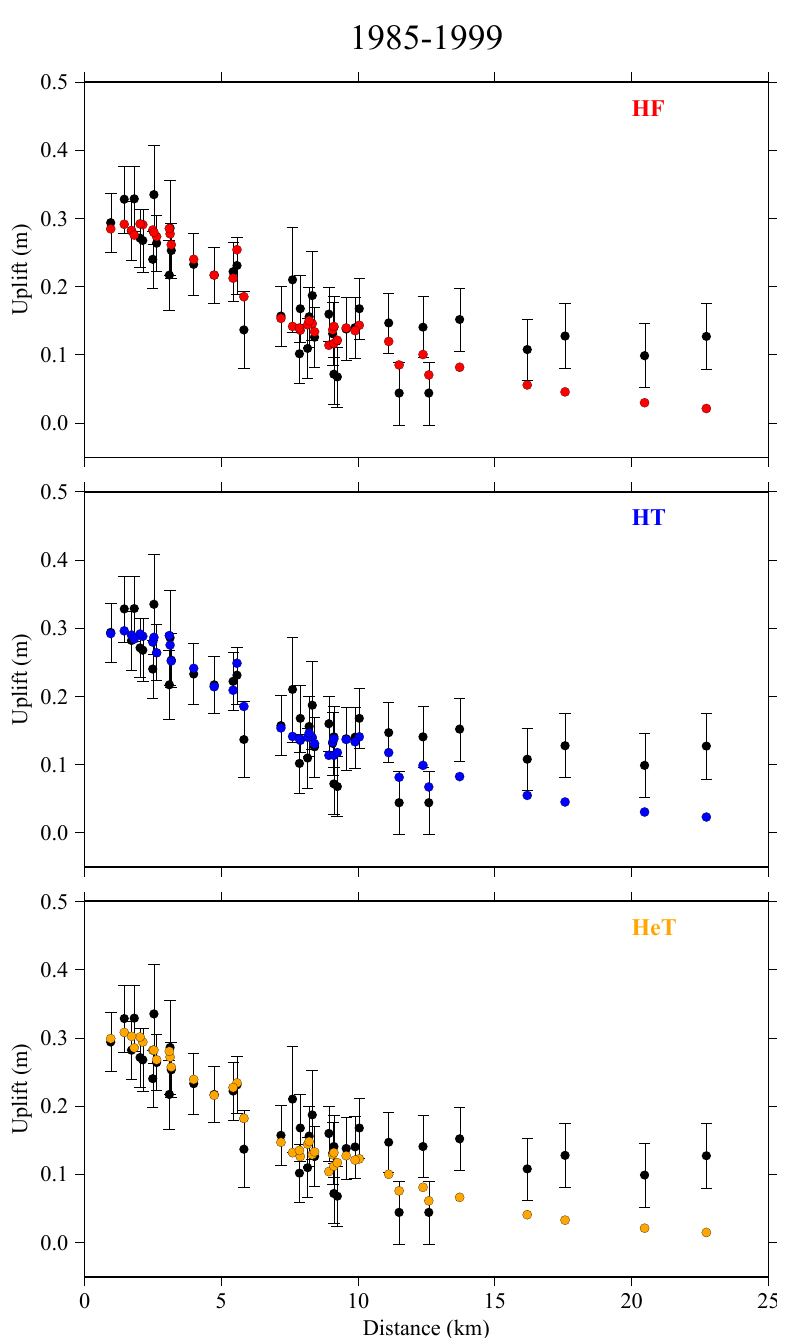
Figure 8. Comparison between observed (black circles with 1-sigma error bars) and modeled (colored circles corresponding to different model configurations) uplift at leveling benchmarks for the data 1985–1999 ordered according to the horizontal distance from the resurgent dome center. HF: homogeneous flat crust; HT: homogeneous crust with topography; HeT: heterogeneous crust with topography.